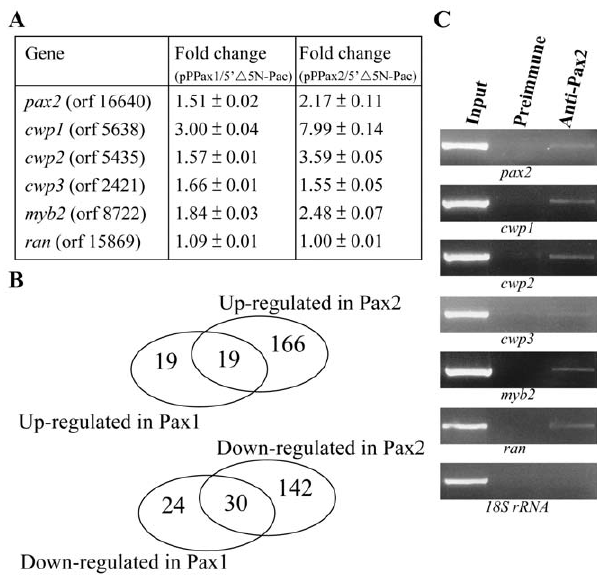
Figure 9. Recruitment of Pax2 to the cwp1-3 and myb2 promoters. (A) Microarray analysis. Microarray data were obtained from the 5 9 n 5N-Pac and pPPax1 (or pPPax2) cell lines during vegetative growth. Fold changes are shown as the ratio of transcript levels in the pPPax1 (or pPPax2) cell line relative to the 5 9 n 5N-Pac cell line. Results are expressed as the means 6 standard error of at least three